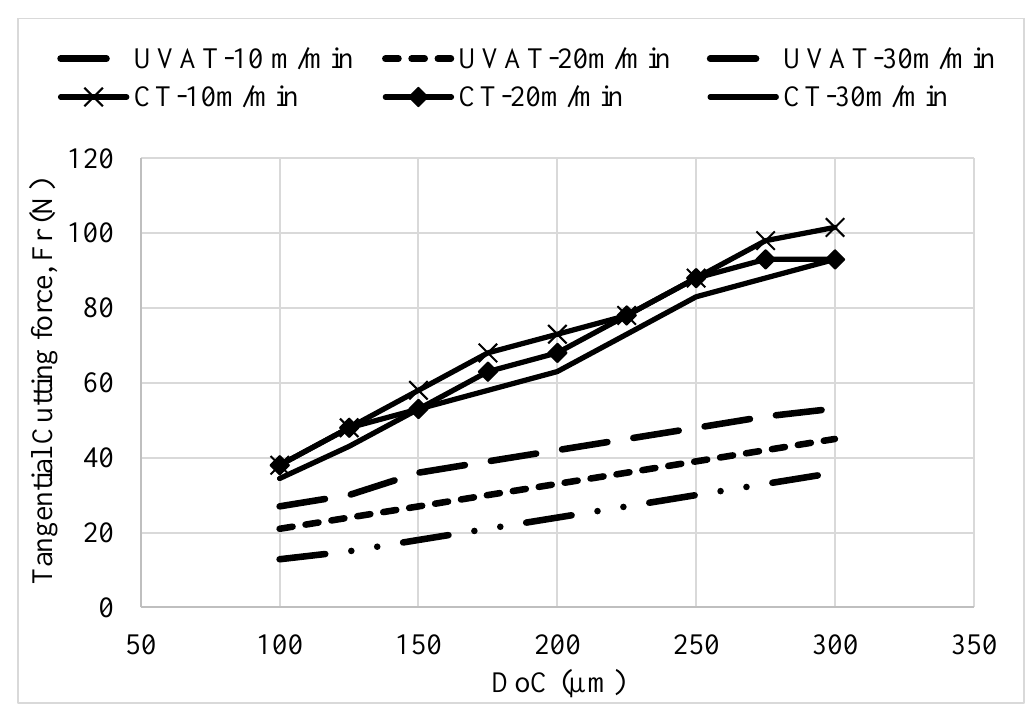
Figure 5. The predicted Ft in CT and UVAT.